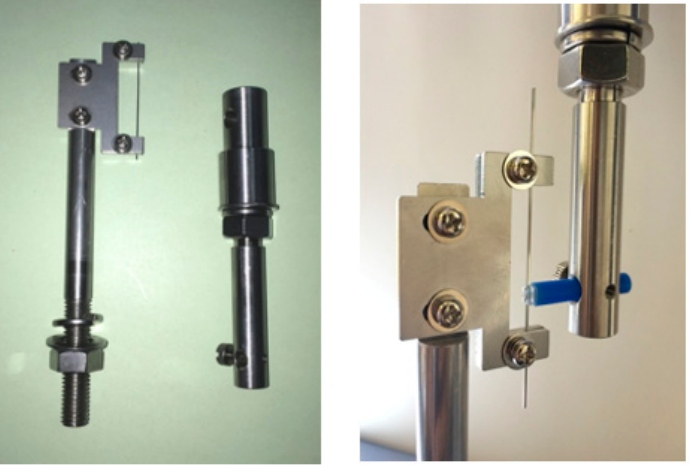
Figure 1. Friction jig and friction test.